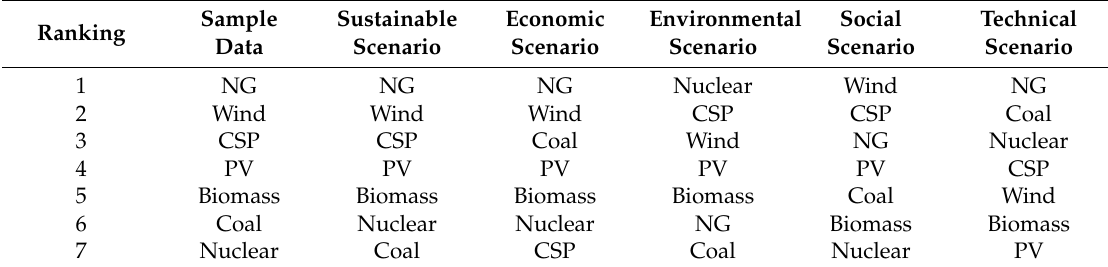
Table 10. Ranking of the technologies in the six